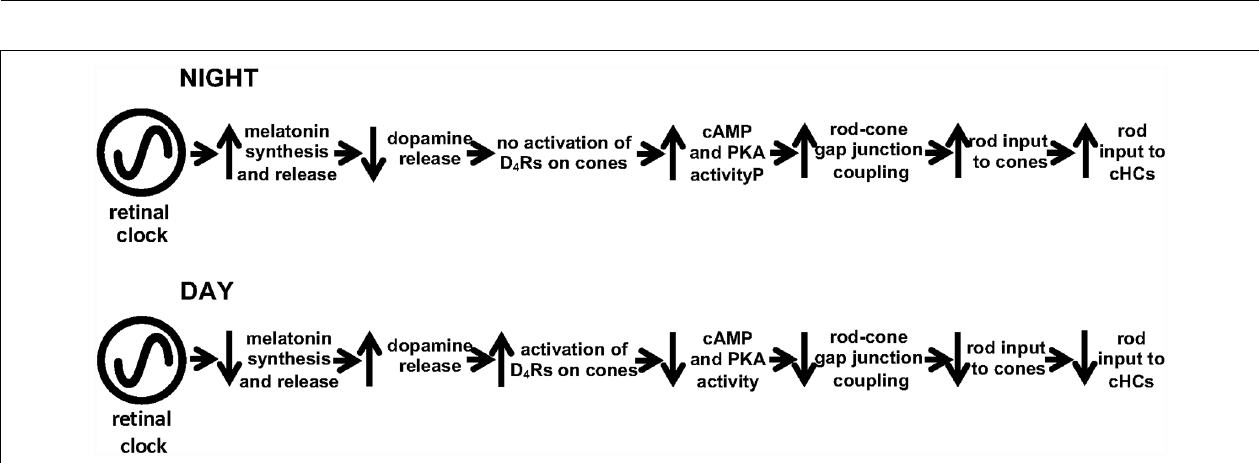
FIGURE 14 | Summary of how the retinal circadian clock uses D 4 receptors to control rod-cone gap junction coupling. During the subjective night, the circadian clock decreases dopamine release from dopaminergic neurons so that cone D 4 Rs are NOT activated, which increases intracellular cAMP/PKA. This increases rod-cone coupling (i.e., increases the conductance of rod-cone gap junctions) and the amount of rod input that reaches cones and cHCs. Conversely, during subjective day, the circadian clock in the retina increases dopamine release from dopaminergic neurons, activating D 4 Rs on rods and cones. This in turn decreases cAMP/PKA, so that the conductance of rod-cone gap junctions and the amount of very dim light rod signals that reaches cones and cHCs are